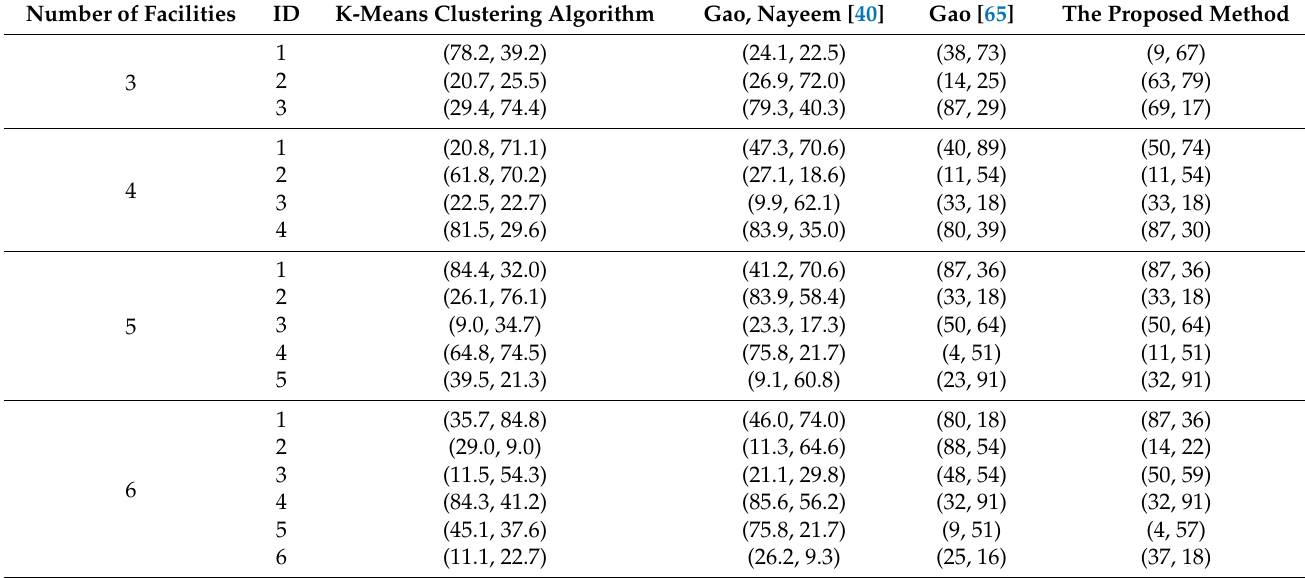
Table 8. Comparison of facility locations using different methods for Instance 26.